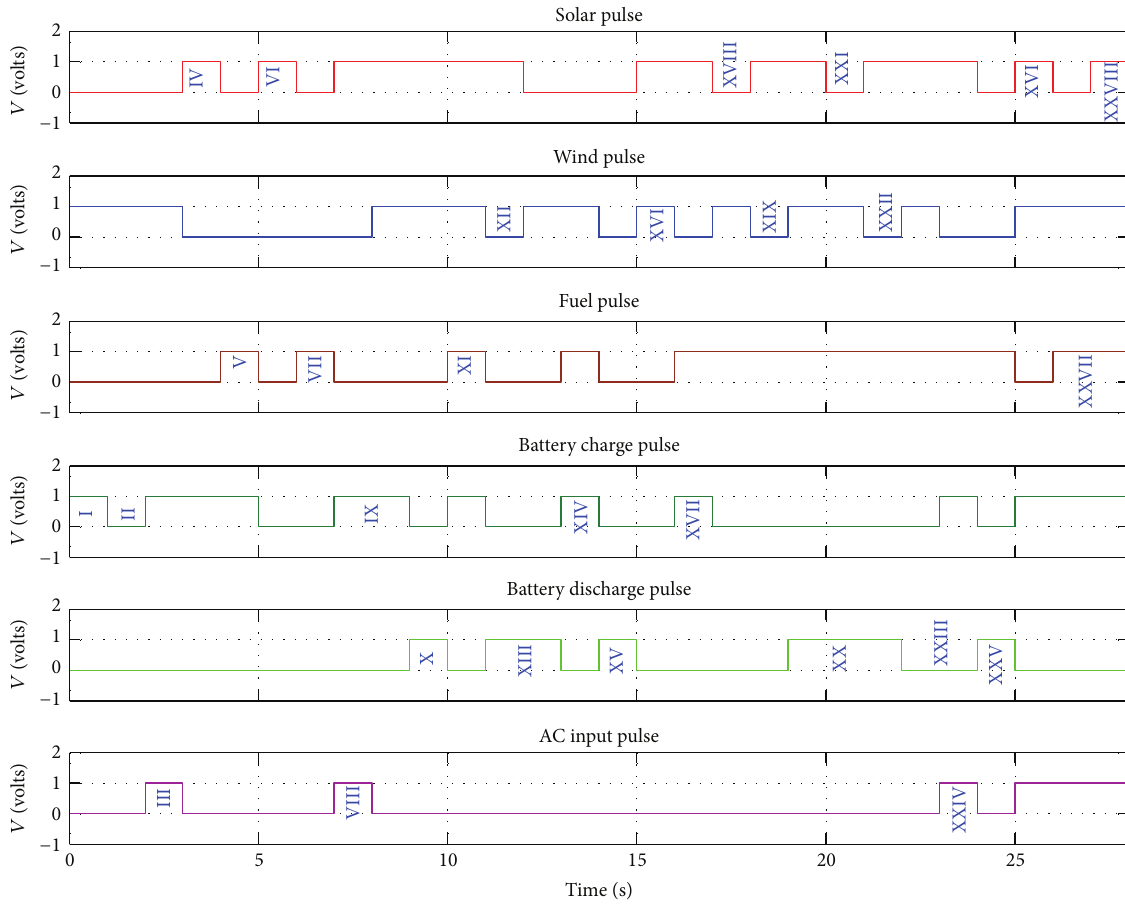
Figure 20: Possible combinations of sources to meet the load